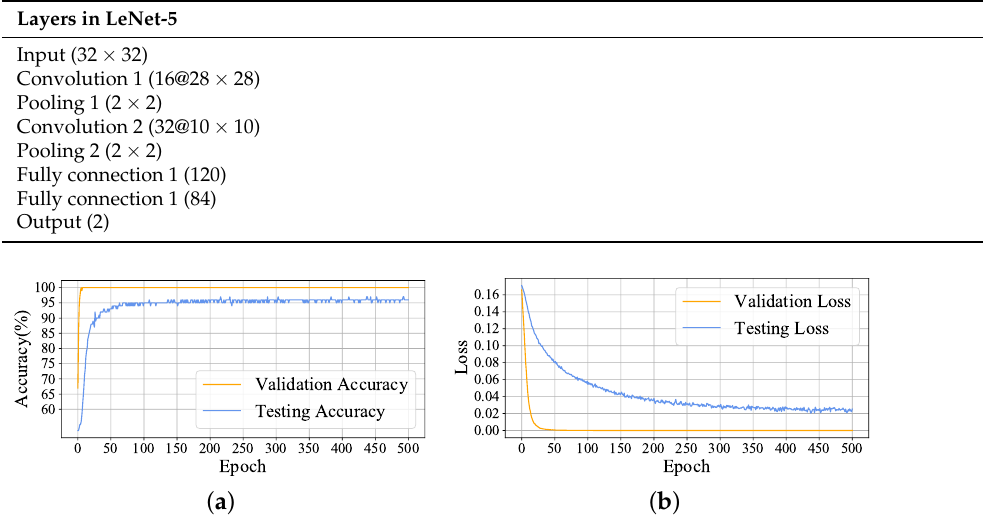
Table 5. Structure of LeNet-5 model. Layers in LeNet-5